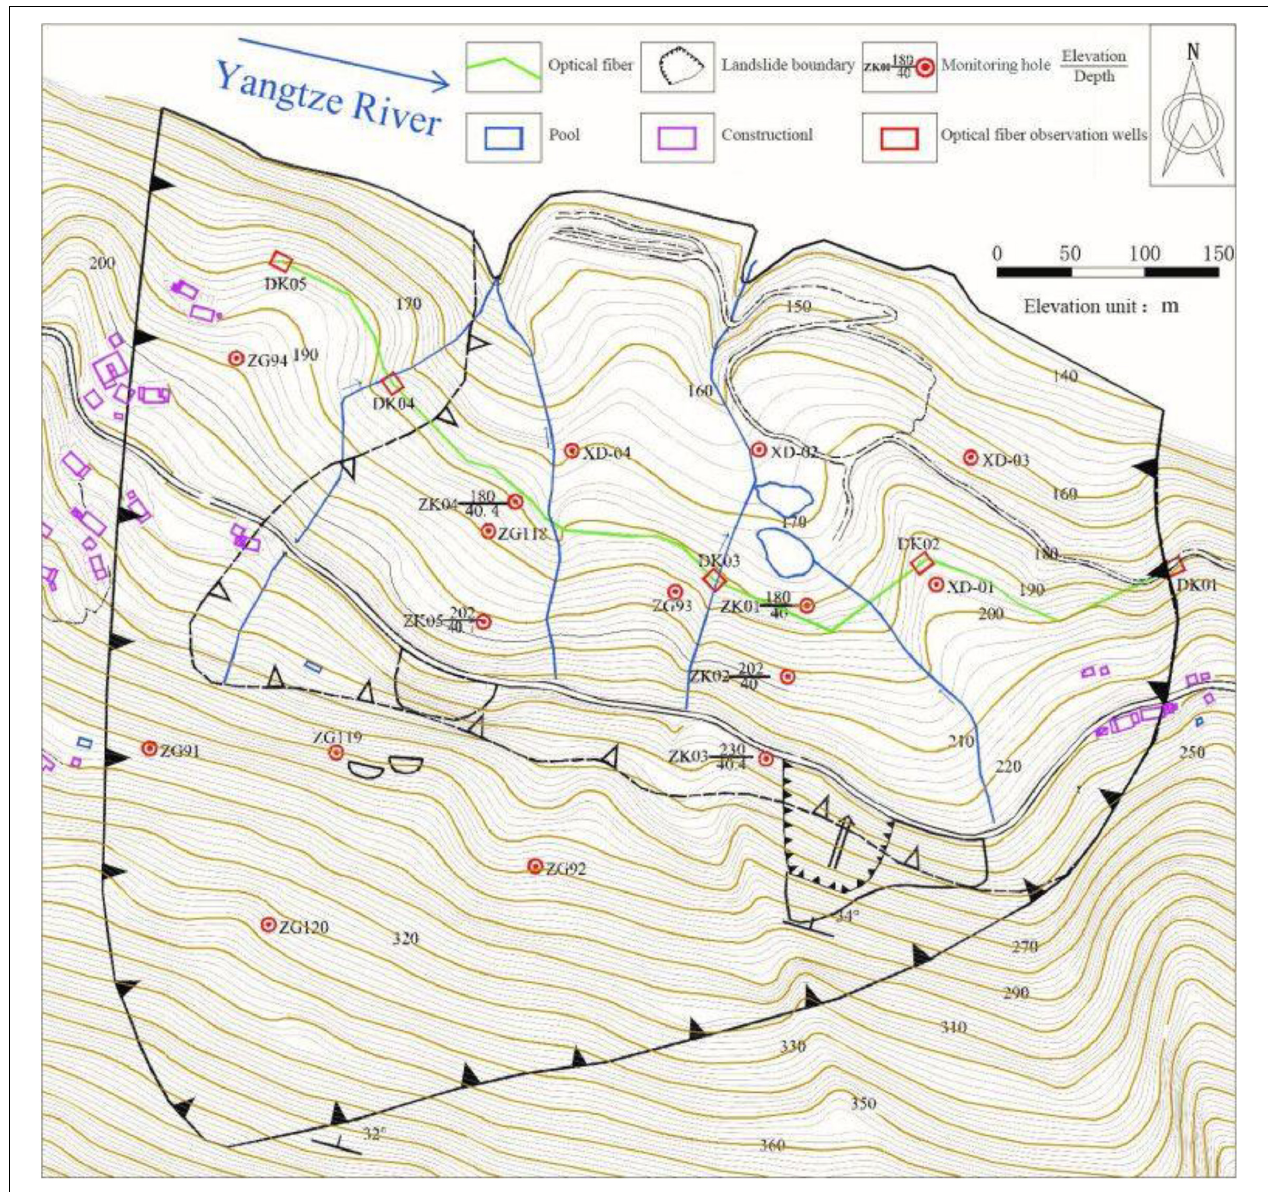
FIGURE 2 | Engineering geological map of the Baishuihe